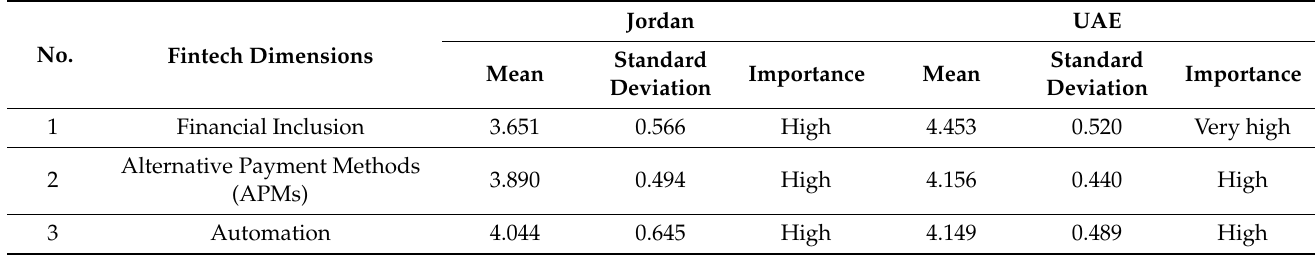
Table 5. Results of the Descriptive Analysis of FinTech Dimensions.